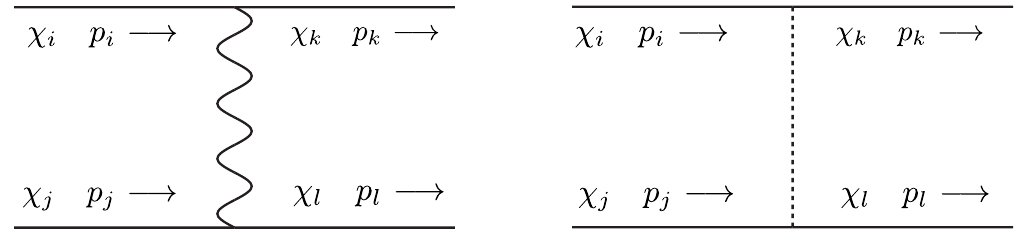
Figure 14 . 2-2 diagram interchanging a dark photon (left) and a Goldstone boson